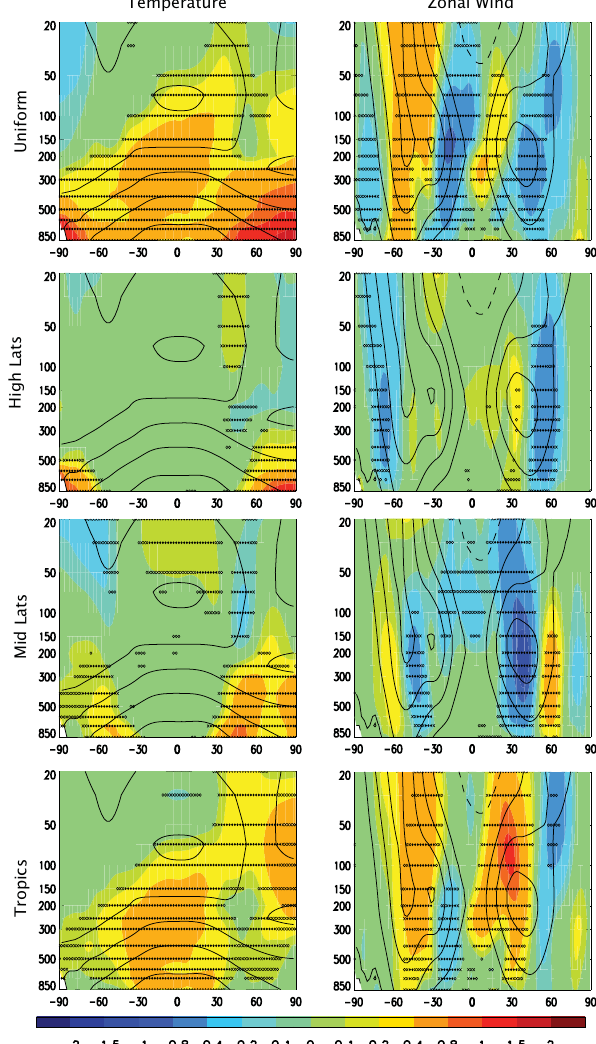
Fig. 6. Zonal annual mean temperature (left) and zonal wind (right) response to heating (0.2Kday − 1 ) the lower troposphere using the GFDL AM2.1 model. Symbols represent significance at the 90% (diamond); 95% (cross) and 99% (dot) confidence level. Clima- tological U contour interval (thin black) is 10ms − 1 with negative values dashed. Climatological T contour interval is